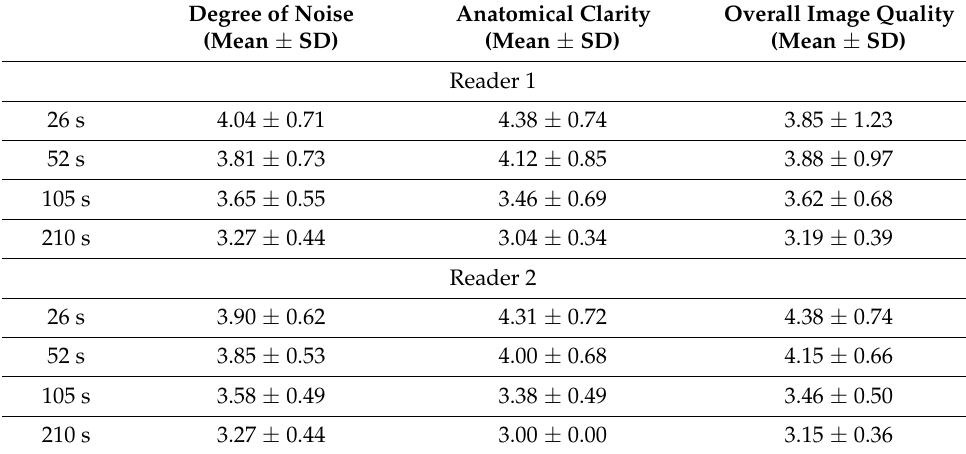
Table 1. Visual analysis of the synthetic and original low-count images. Degree of Noise Anatomical Clarity (Mean ± SD) (Mean ±